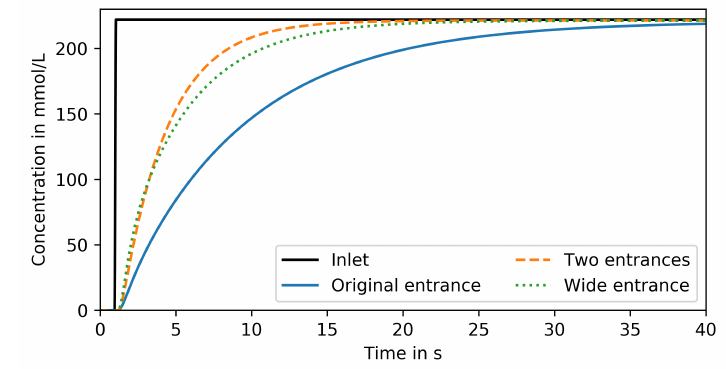
Figure 7. Reproduced signal in trapping region of MGC devices with varied entrance size and position for step change